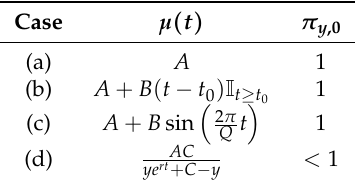
Table 6. Some choices of µ ( t ) and the corresponding extinction probabilities. Parameters A , B , Q , and t 0 are positive